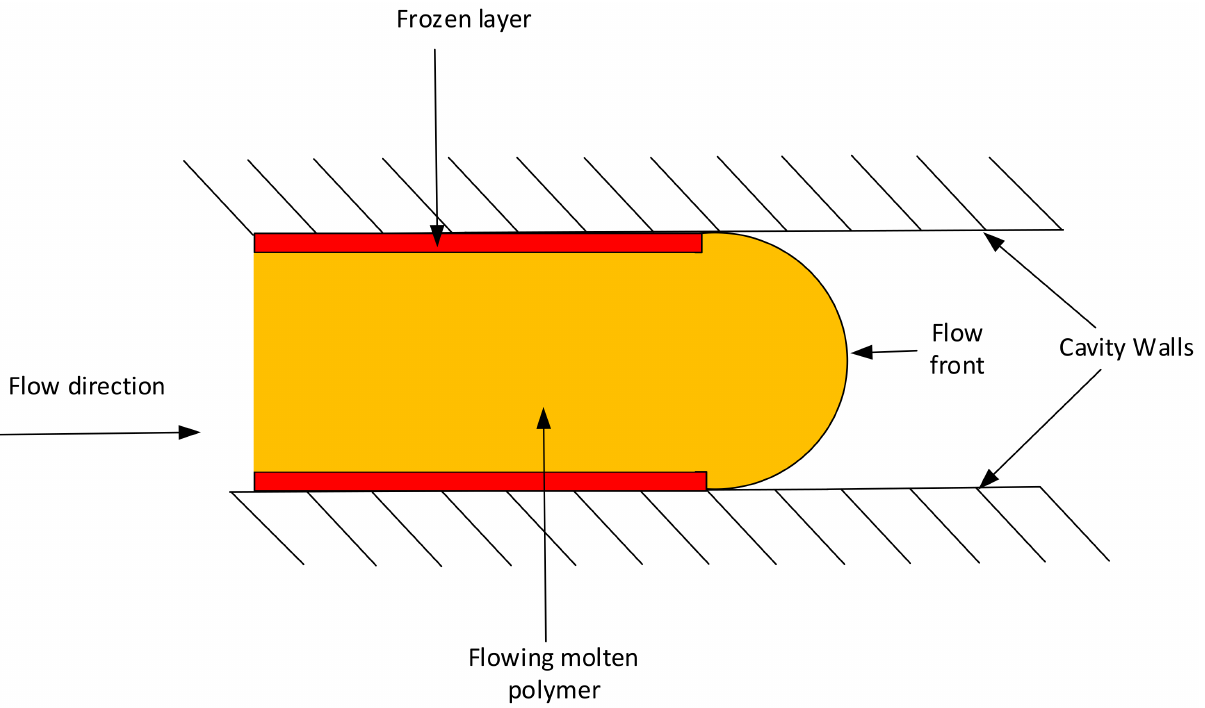
Figure 18. Flow of molten polymer inside the cavity showing frozen